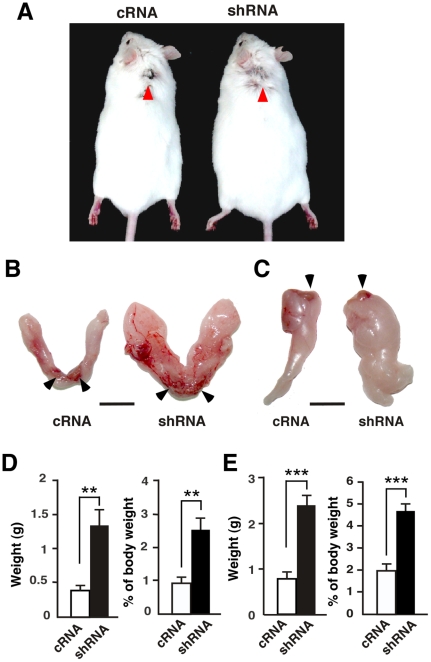
Lentivirus-mediated necdin knockdown enhances WAT expansion in vivo.(A) Representative mice infected with lentivirus vectors for control scrambled RNA (cRNA) and necdin shRNA (shRNA). Mice were infected with the recombinant lentiviruses at 5 weeks of age and subsequently fed a high-fat diet for 6 weeks. Red arrowheads point to the injection sites in the interscapular WAT. (B, C) Representative interscapular (B) and epididymal fat pads (C). WATs were excised from lentivirus-infected mice. Arrowheads point to brown fat depots (B) and testes (C) attached to the fat pads for orientation. Scale bars, 1 cm. (D, E) White fat pad weight. Interscapular (D) and epididymal (E) white fat pads excised from lentivirus-infected mice fed the high-fat diet were weighed after removing non-white-adipose tissues. Absolute (left) and relative values (right) are shown (mean ± SEM, n = 4). **P<0.01, ***P<0.001.